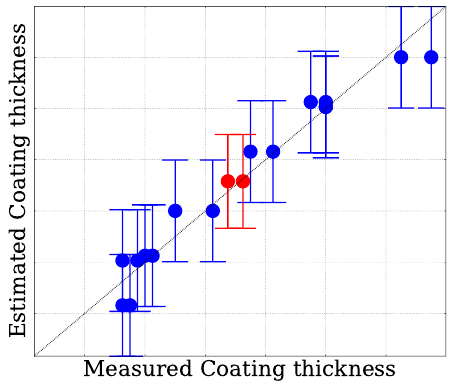
Figure 11: Measured and estimated coating thickness